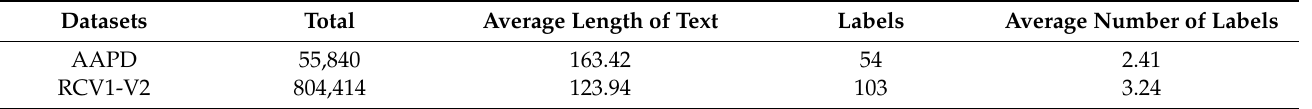
Table 1. The statistics of AAPD and